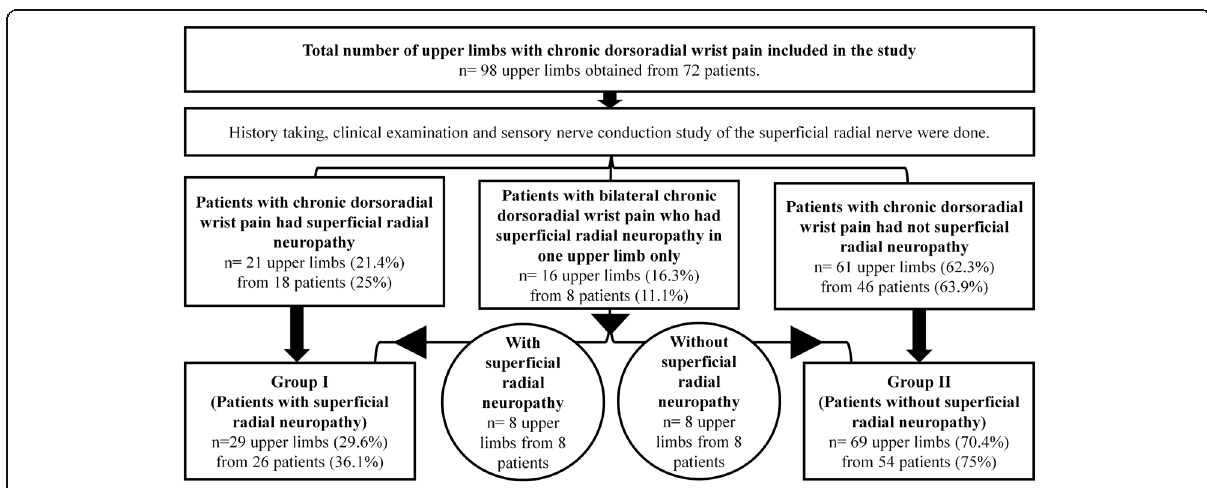
Fig. 7 An illustration representing the study flow chart of patients with chronic dorsoradial wrist pain. Among all participated patients, there were 26 patients (36.1%) with bilateral complaint. There were eight patients (11.1%) with bilateral chronic dorsoradial wrist pain who had superficial radial neuropathy unilaterally. Among group I, there were three patients (11.5%) who had bilateral superficial radial neuropathy. Among group II, bilateral upper limbs affection were obtained from 15 patients (27.8%). n, number